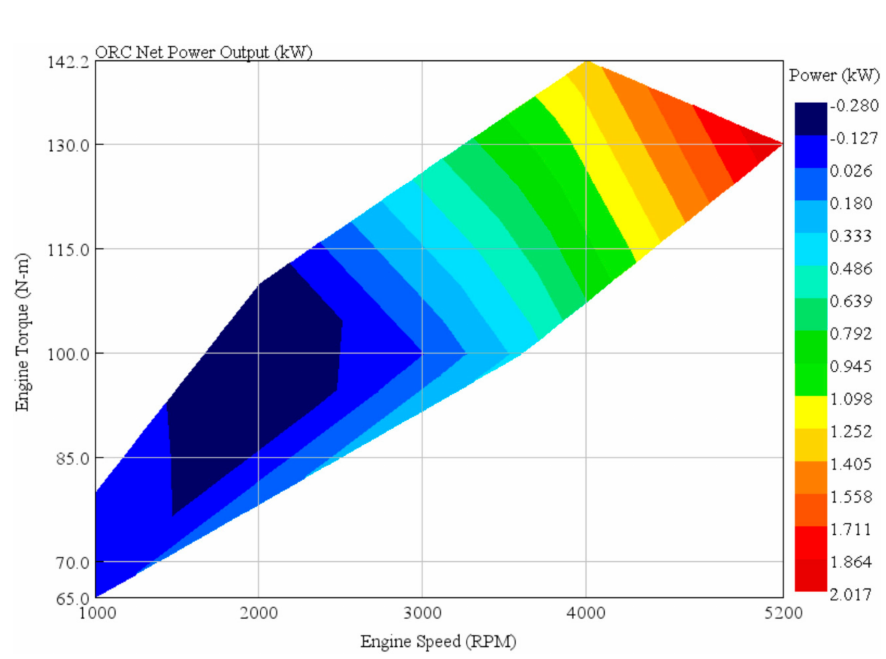
Figure 21. ORC Net Power